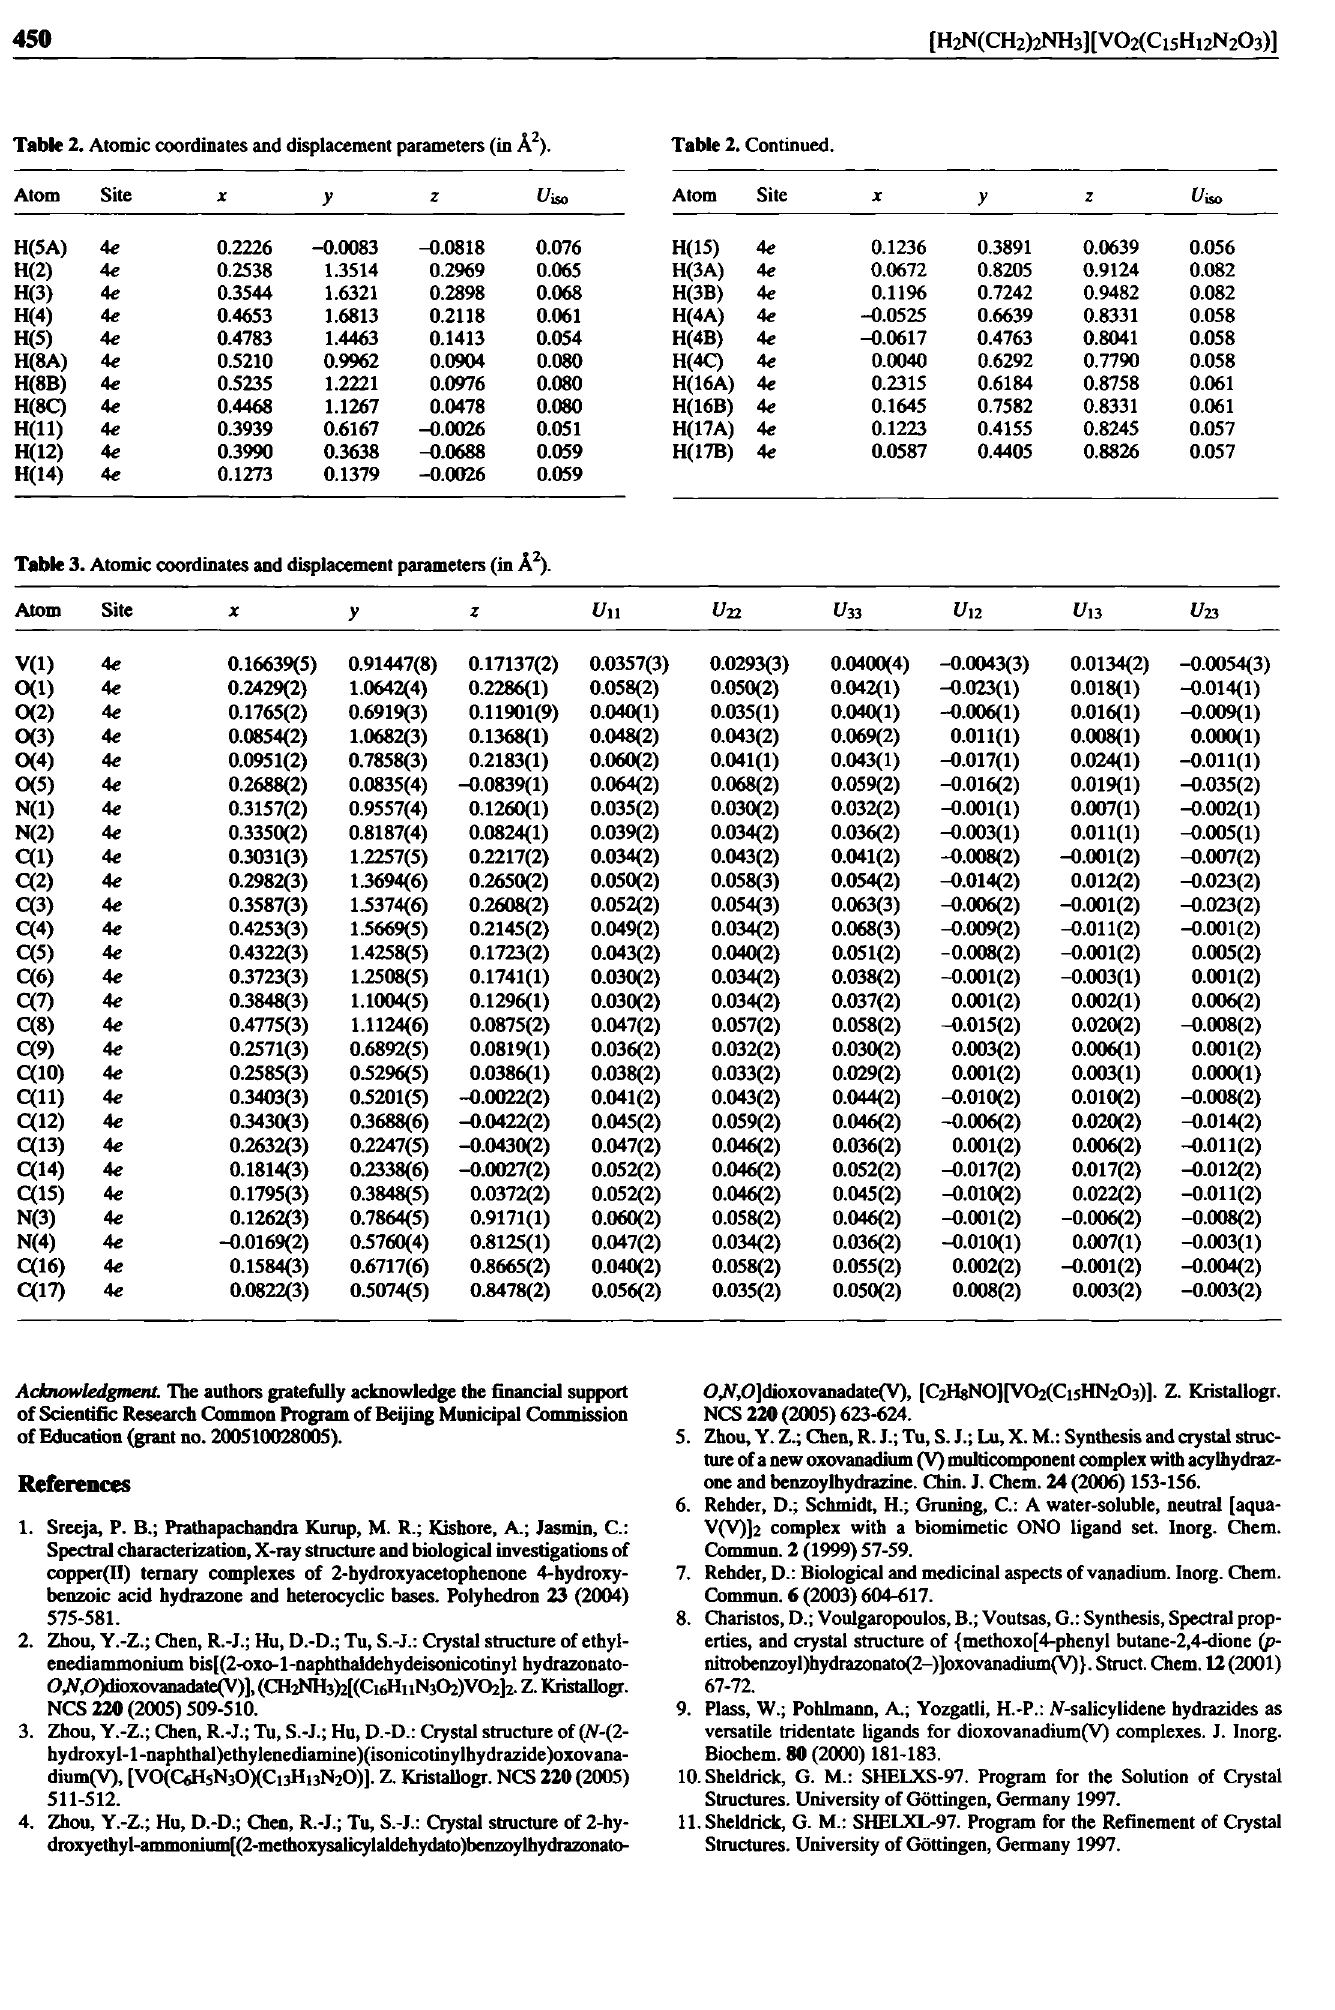
Table 3. Atomic coordinates and displacement parameters (in A 2